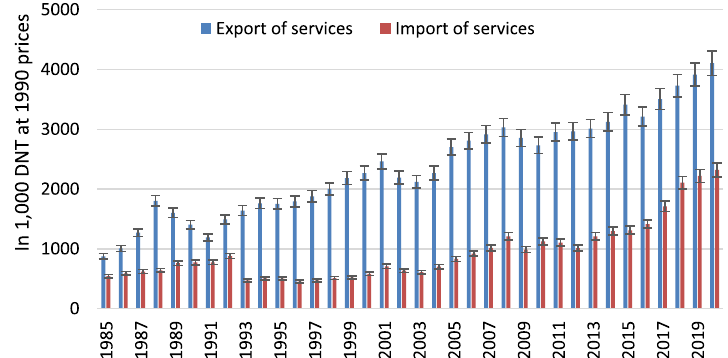
Fig. 3 Evolution of Tunisia’s export and import of services at 1990 prices. Source Compiled by the author from data collected from several issues of the Statistical Yearbook of Tunisia (NIS